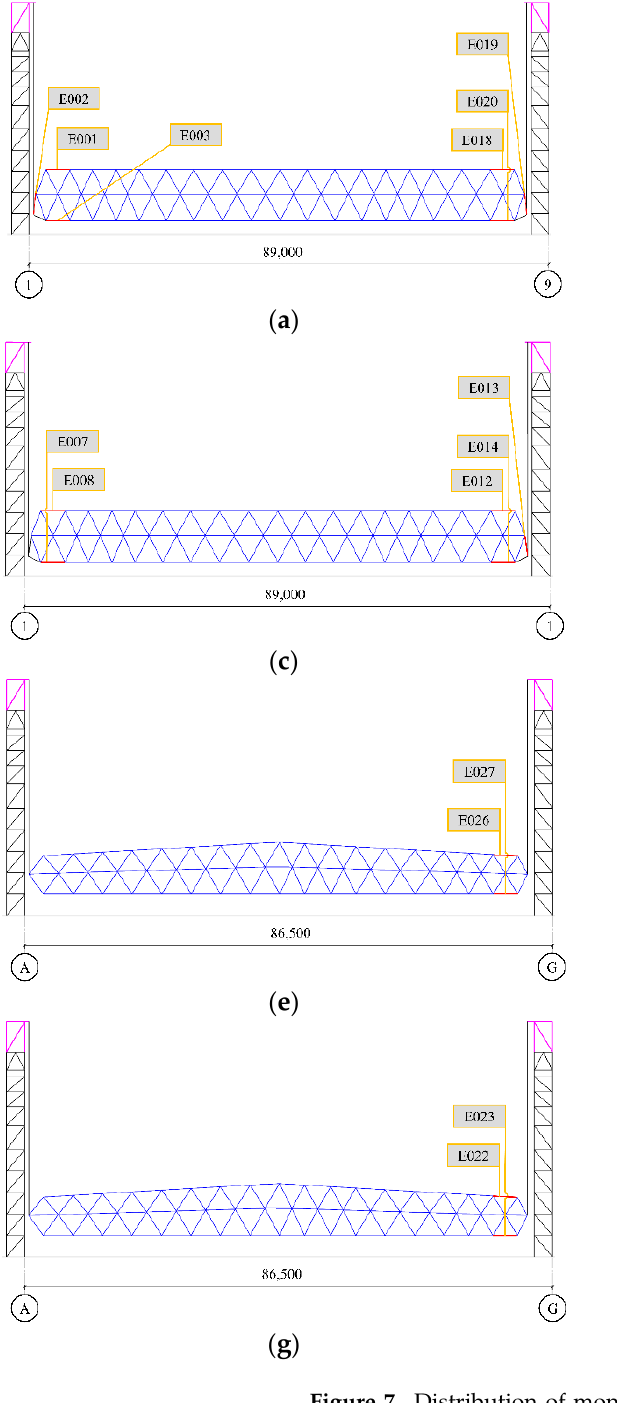
Figure 7. Distribution of monitoring points in the section: ( a ) F-axis section; ( b ) D-axis section; ( c ) B-axis section; ( d ) 3-axis section; ( e ) 4-axis section; ( f ) 5-axis section; ( g ) 6-axis section; ( h ) 7-axis section. (Note: E stands for monitoring point number letter.)